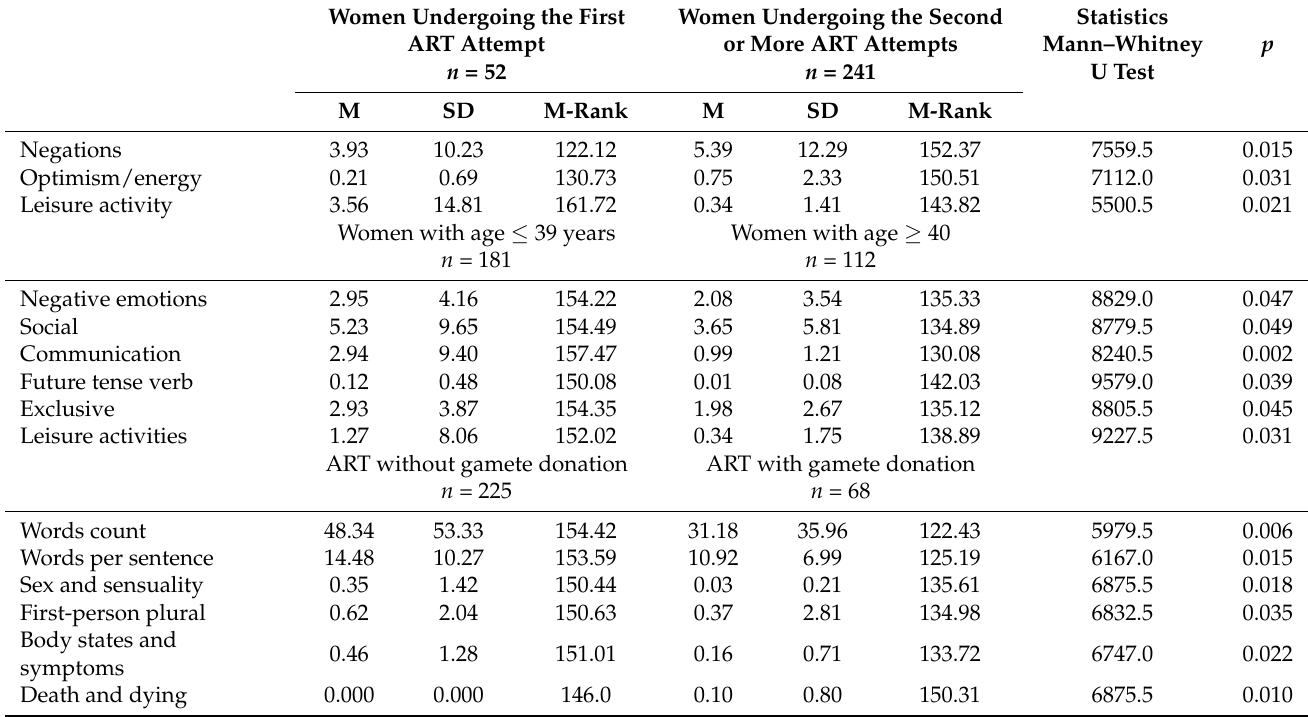
Table 3. Significant differences in linguistic dimensions between groups of women with different socio-anamnestic characteristics.